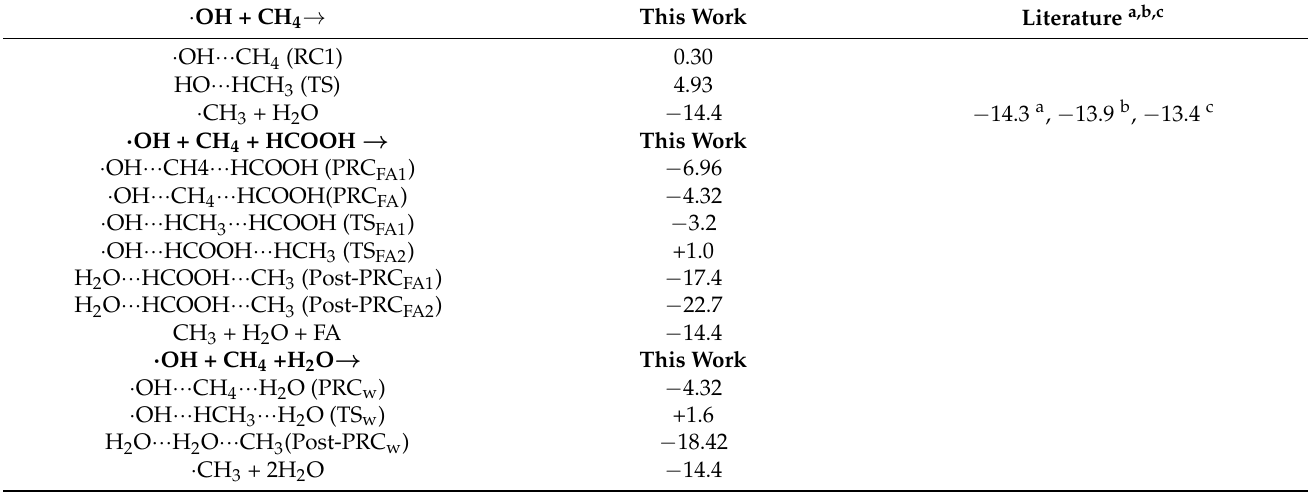
Table 1. Enthalpies of reaction ( ∆ H rxn (0 K )) in kcal mol − 1 of · OH + CH 4